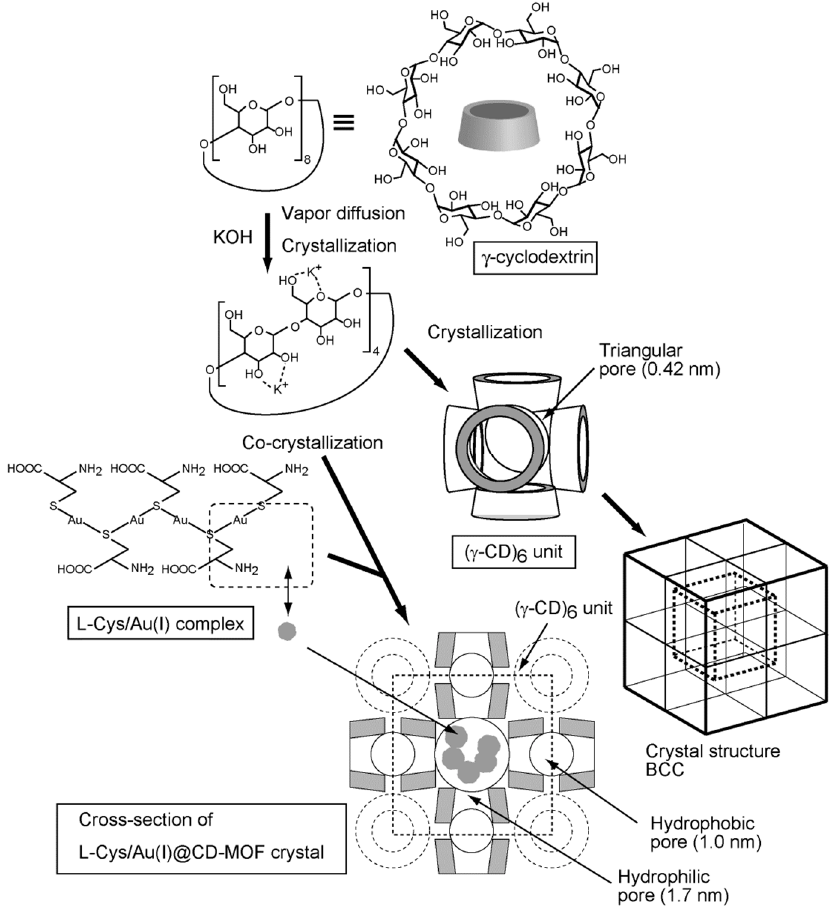
Figure 1. Schematic of the synthesis of L-Cys/Au(I)@CD-MOF.